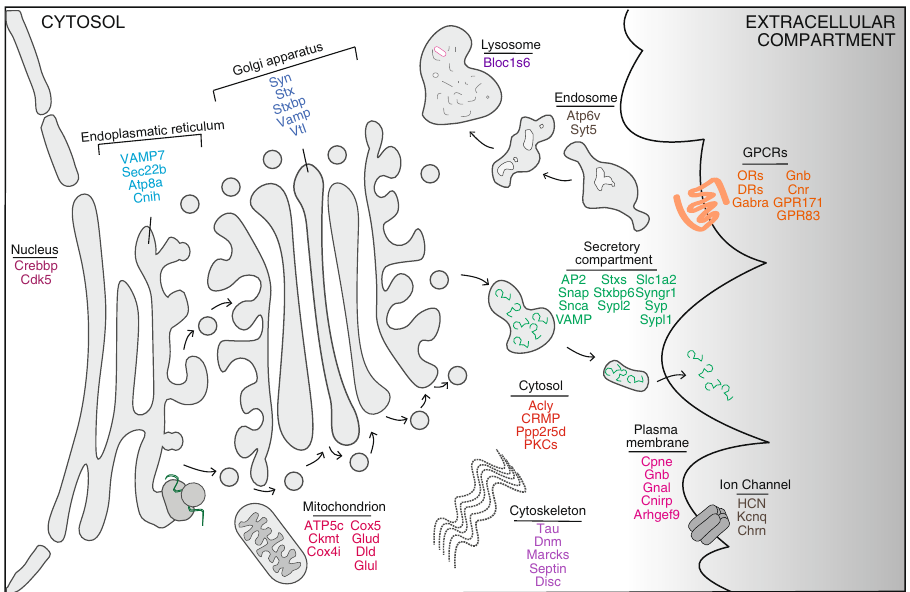
Fig. 1 Schematic representation of synaptic related proteins used to generate antigenic peptides for production of recombinant antibodies. The proteins and their subcellular localization are represented in the carton that highlights synaptic